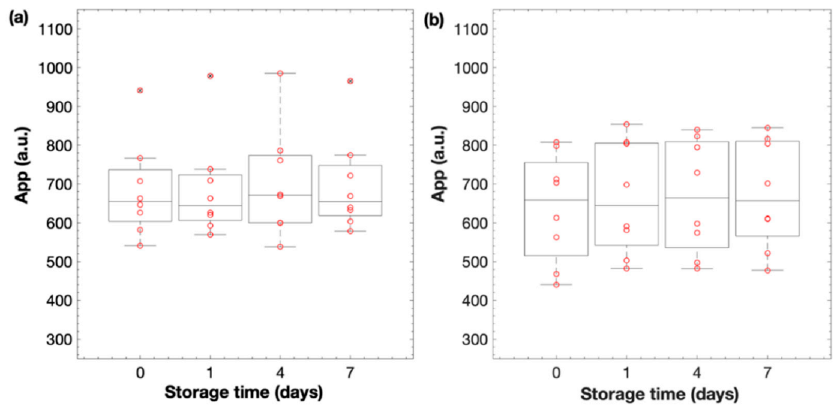
Figure 6. Distribution of the ESR signal peak-to-peak amplitude (App) from non-chemically treated unirradiated fingernail samples stored inside the ( a ) vacuum chamber with 2% air humidity at 20 ◦ C and ( b ) freezer with 3% air humidity at − 20 ◦ C recorded at di ff erent